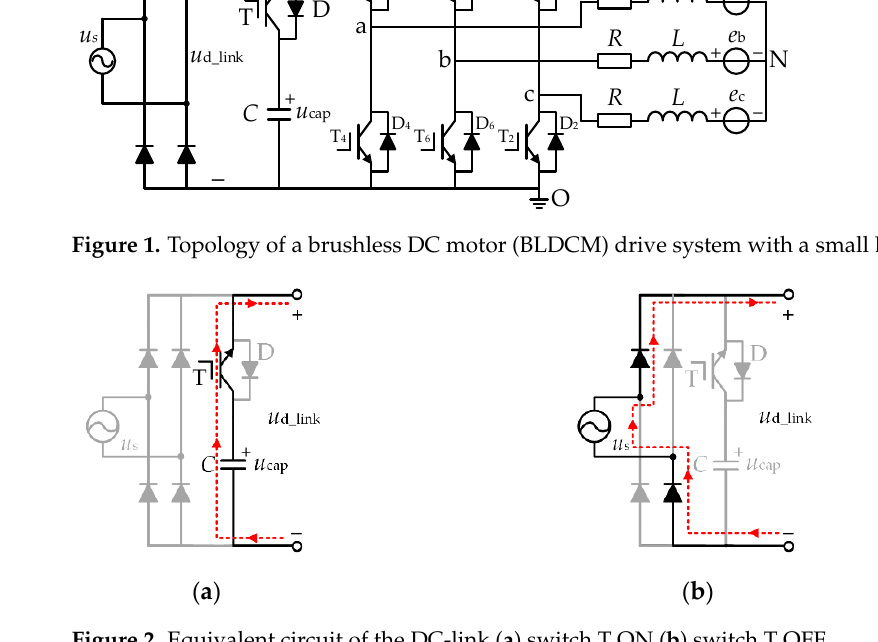
Figure 2. Equivalent circuit of the DC-link ( a ) switch T ON ( b ) switch T OFF.